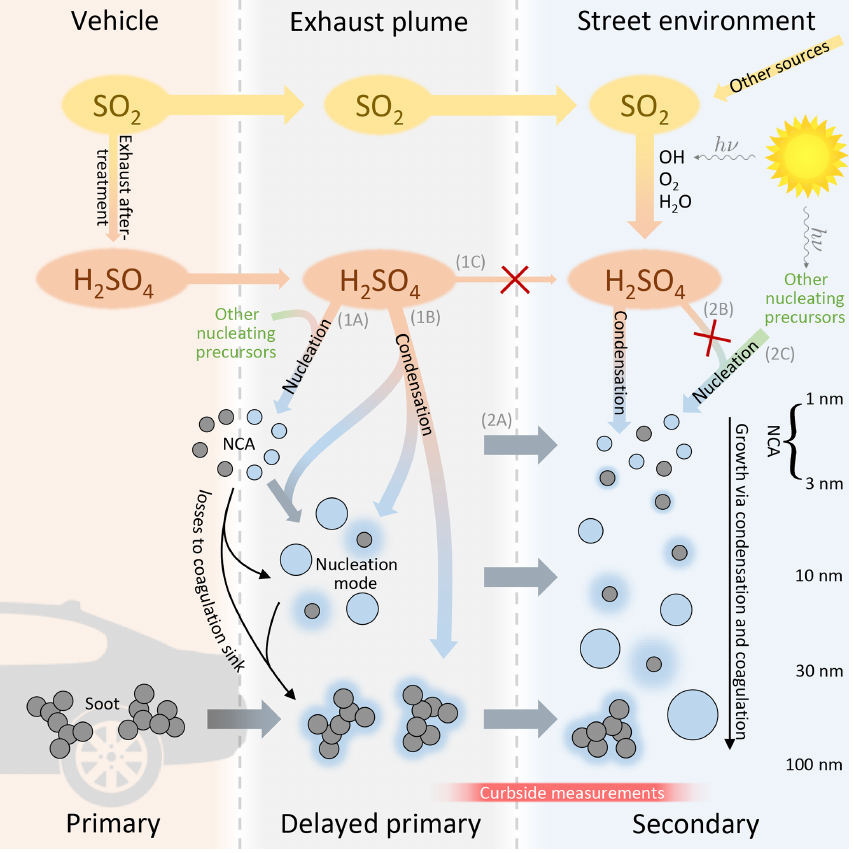
Figure 4. Proposed mechanism of sulfuric acid and particle formation in traffic-influenced areas. The route of primary H 2 SO 4 to the urban atmosphere (route 1C) is largely terminated to the particle phase rapidly after the emission (routes 1A and 1B). Conversely, secondary H 2 SO 4 remains in the urban atmosphere because it does not experience such a rapid gas-to-particle conversion. NCA presence in the urban atmosphere is majorly controlled by traffic emissions (route 2A) and only marginally by nucleation from secondary precursors (routes 2B and 2C); in particular the contribution of nucleation from secondary H 2 SO 4 (route 2B) is noticeably overridden by traffic emissions (route